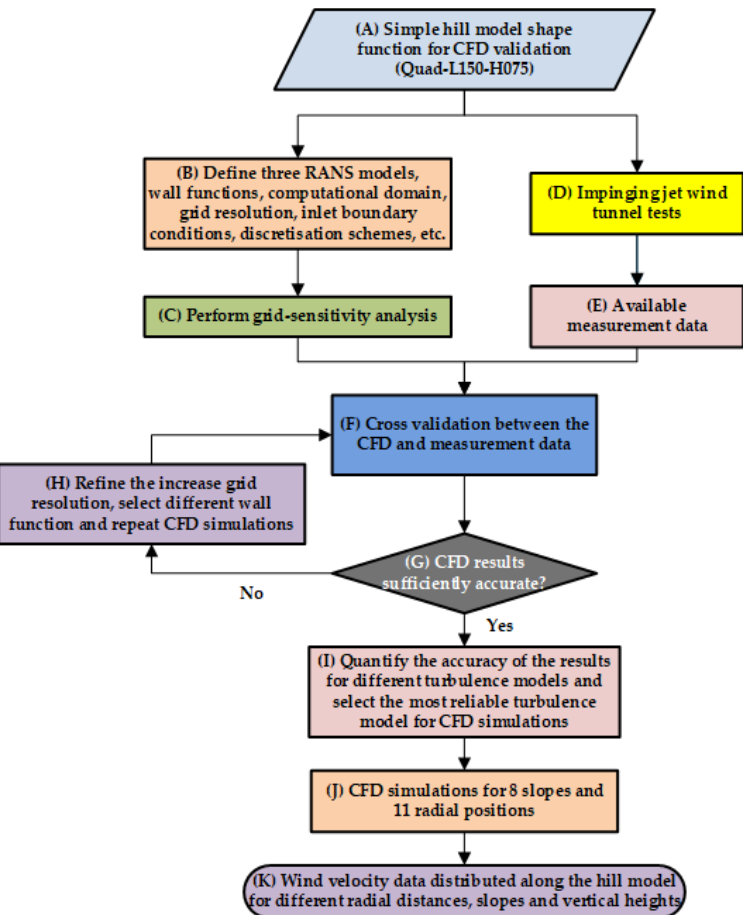
Figure 1. Flowchart illustrating the methodology for numerical simulations.